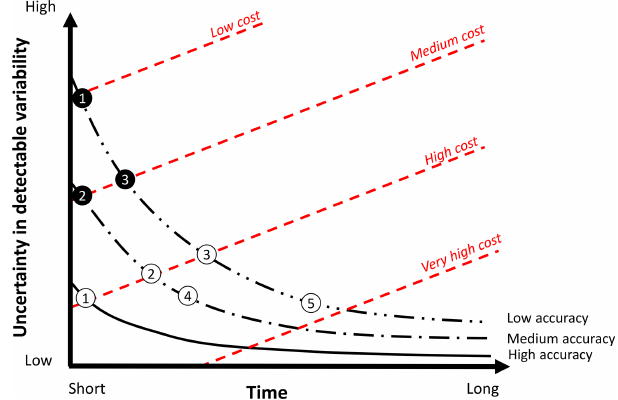
Figure 6. A conceptual diagram showing the uncertainty of de- tectable variability as a function of greenhouse gas measurement accuracy, time, and cost. Adopted from Baldocchi et al. (2018). Dashed red lines indicate different cost, and black lines indicate dif- ferent accuracy. The red and black lines are only theoretical. With a small budget (low-cost technology for a short period), we have a lot of uncertainty in what we can detect (black 1). With a higher budget (moving to the next red line), we can either (i) go for a more accurate method for a short monitoring period (black 2) or (ii) en- sure a longer monitoring period (or more frequent sampling) for the low-accuracy method (black 3). Increasing the budget even more, we have three options for the same budget: (i) a short period with high accuracy (white 1), (ii) a long period with medium accuracy (white 2), and (iii) a longer period with low accuracy (white 3). To achieve a certain level of uncertainty (same value on the y axis) it could be possible to use either (i) high-accuracy technologies for a short-term campaign (white dot 1) or (ii) lower-accuracy technolo- gies for a longer campaign (white dot 4 or